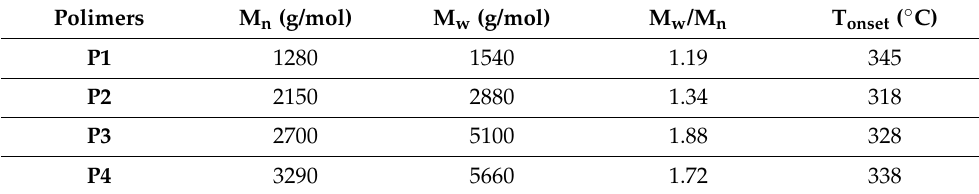
Table 1. Molecular weights (evaluated by GPC in CHCl 3 ) and TGA data of P1 – P4 .